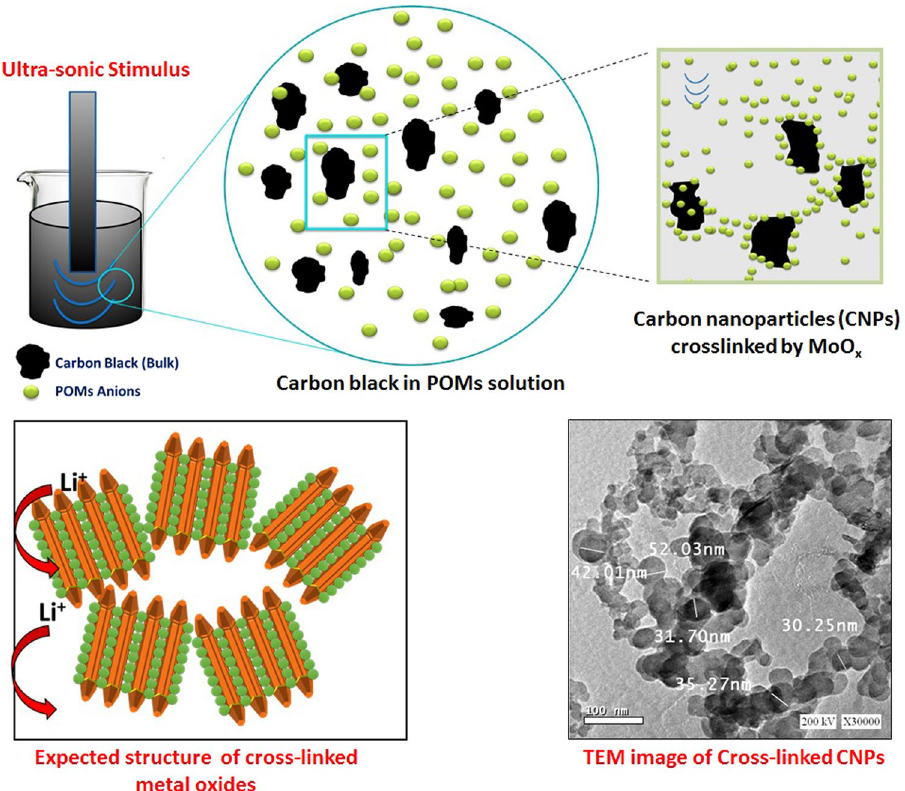
Figure 3. Schematic illustration for the morphology engineering of carbon nanoparticles (CNPs) by top-down approach [Polyoxometalate assisted-solution technique]. Expected structure before SEM inspection of real results is shown